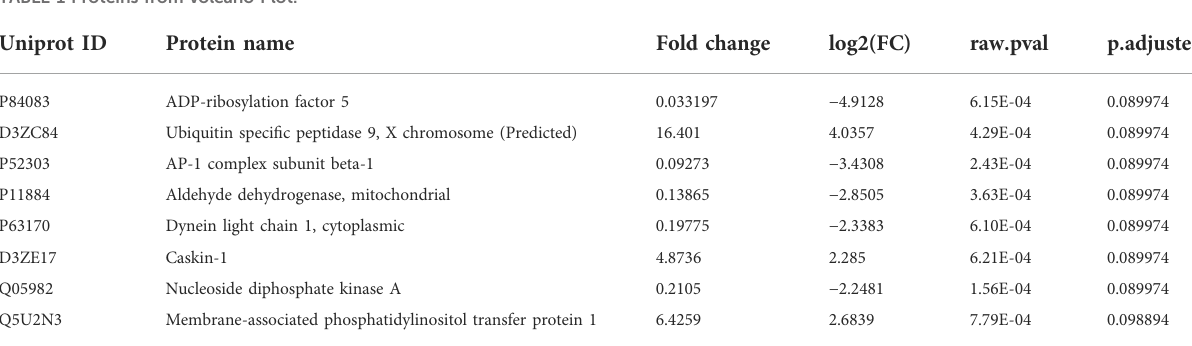
TABLE 1 Proteins from volcano